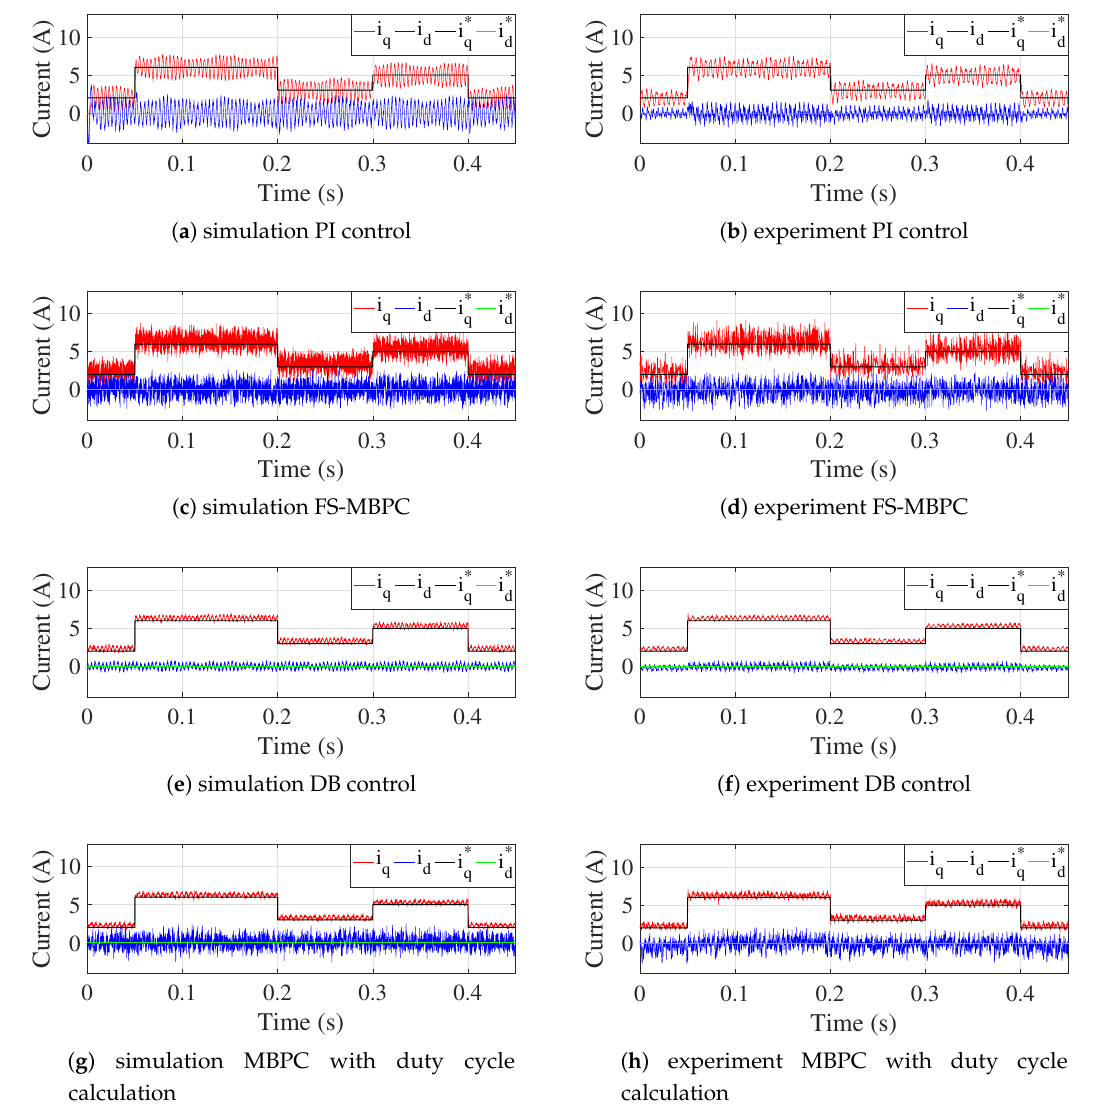
Figure 16. Simulation and experimental results for the stator current components with a defect in the rotor ( N = 800 rpm; V dc = 200